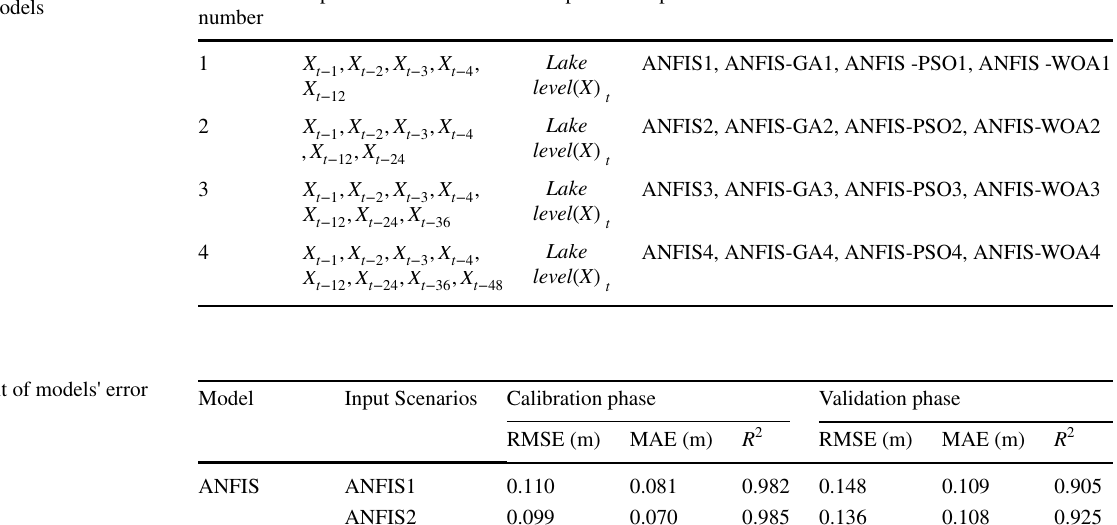
Table 2 Scenarios definition for input of the models